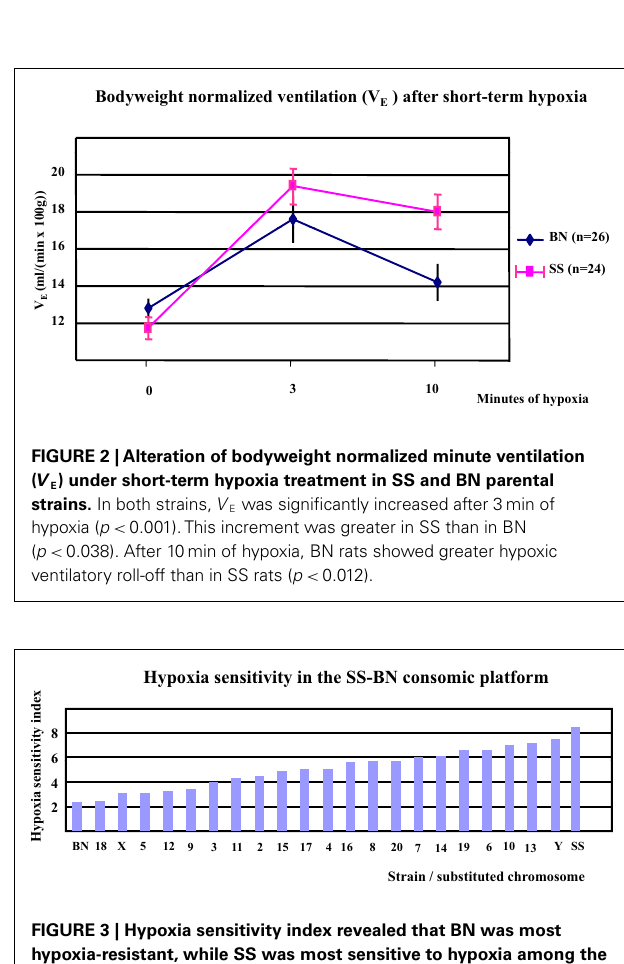
FIGURE 3 | Hypoxia sensitivity index revealed that BN was most hypoxia-resistant, while SS was most sensitive to hypoxia among the SS-BN consomic rat